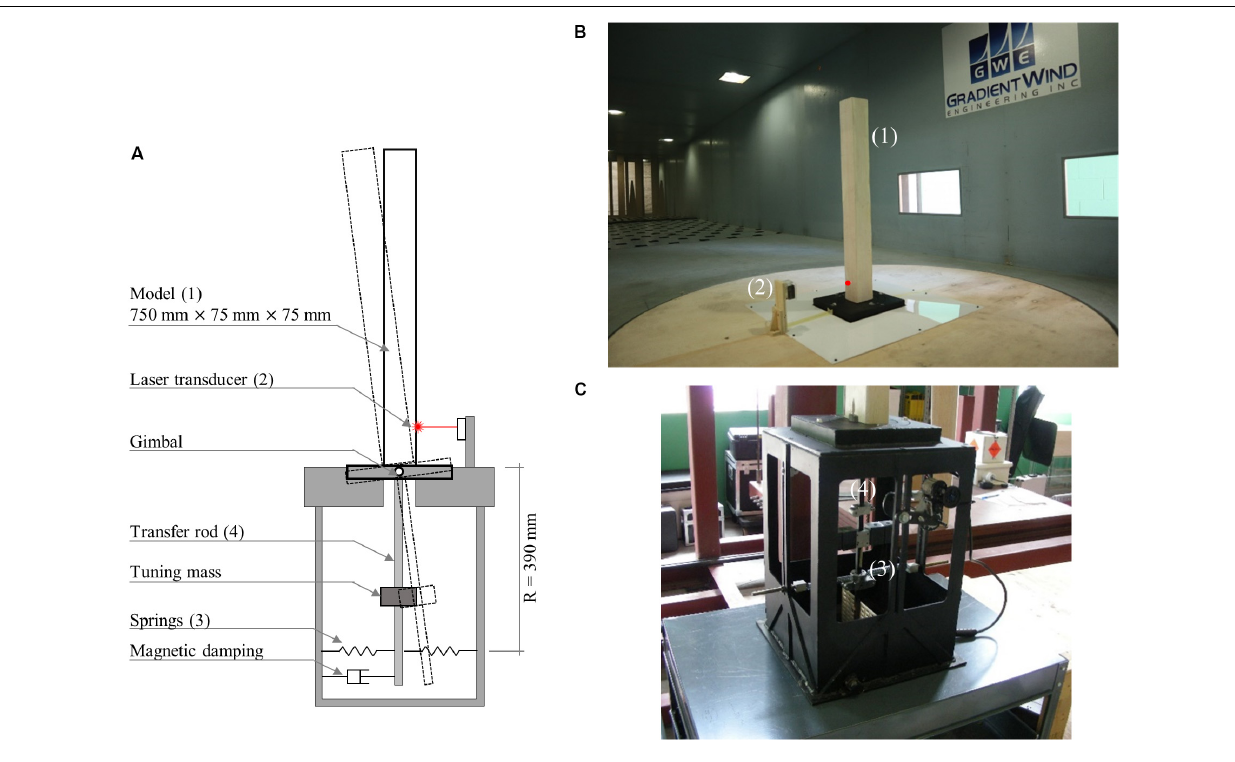
of a specific building, the effective mass density ratios were deemed appropriate. Because of the presence of the damping introduced in the delay, the damping coefficient in Eq. (1) is